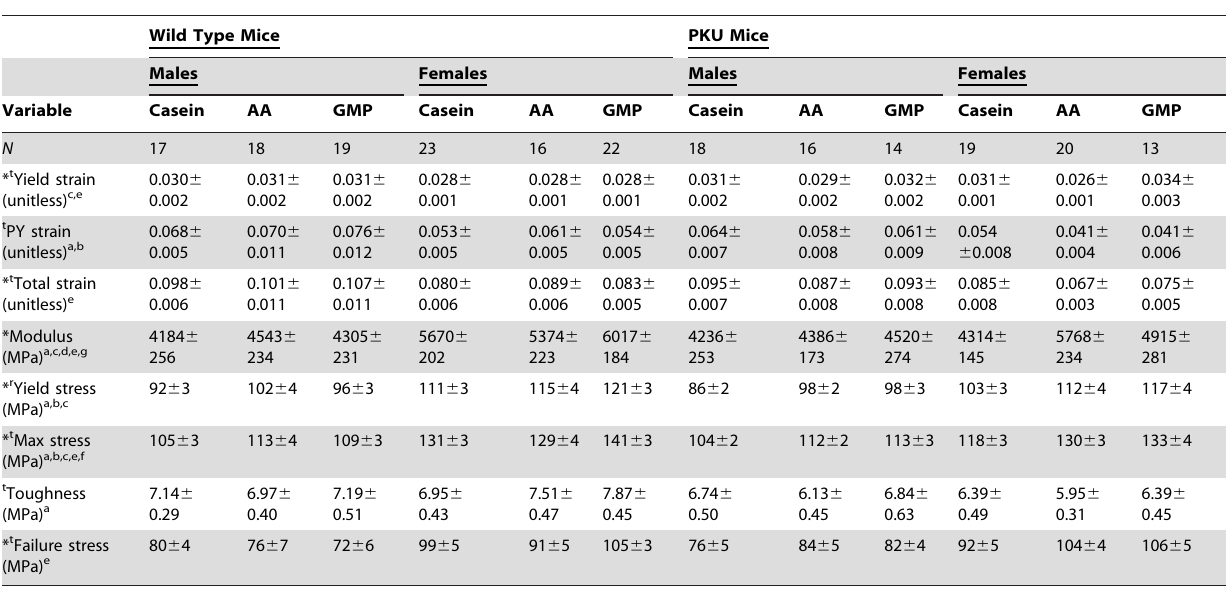
Table 4. Stress-strain curve analysis showing tissue level biomechanical performance.